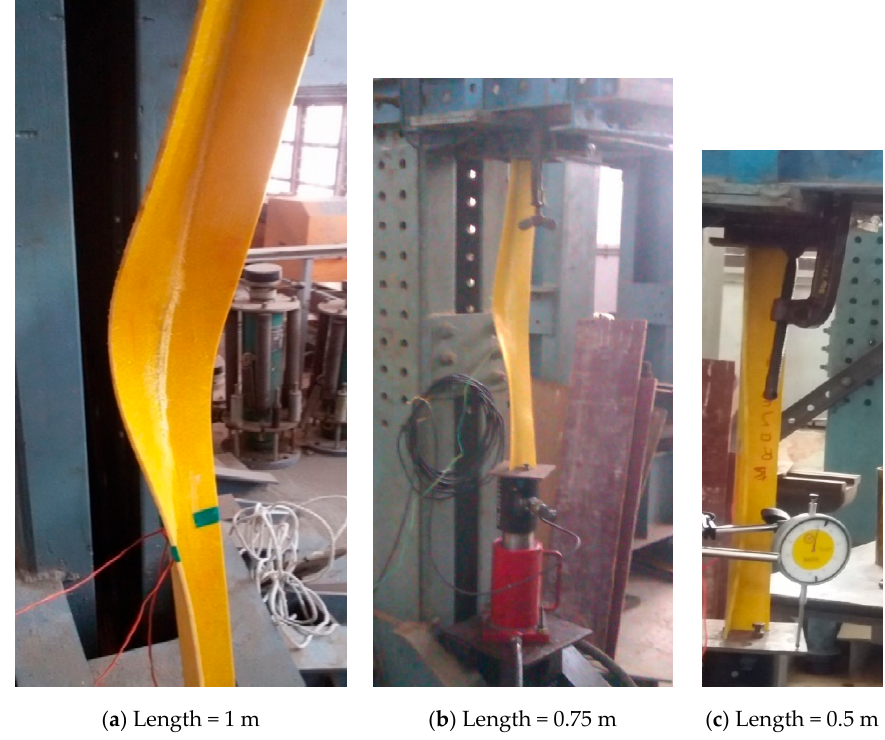
Figure 6. Buckling behavior of GFRP angle sections 50 mm × 50 mm × 4 mm.